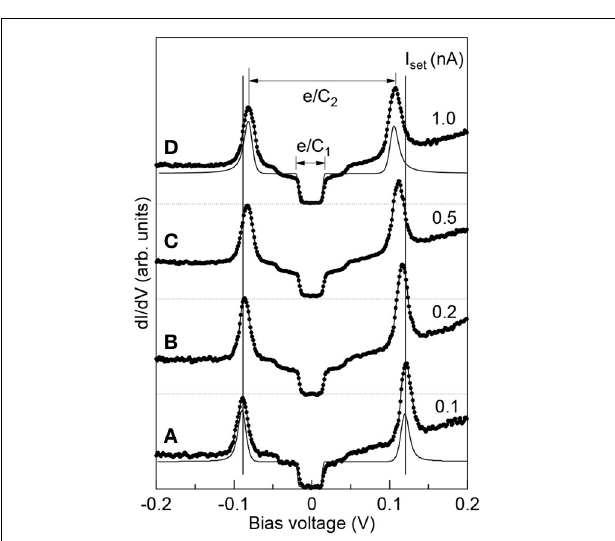
FIGURE 4 | Evolution from Coulomb blockade to Coulomb staircase: experimental STS data acquired on a Pb island with 14nm side ( A island ≈ 85nm 2 ) (dots) and simulation (black line) based on the orthodox theory. The spectra are offset for clarity. Parameters of the simulation: R 1 = 39M (cid:3) , C 1 = 7 . 46aF, and C 2 = 0 . 7aF; (A) : R 2 = 300M (cid:3) and Q 0 = − 0 . 15 e , (B) : R 2 = 105M (cid:3) and Q 0 = − 0 . 2 e , (C) : R 2 = 26M (cid:3) and Q 0 = − 0 . 26 e , (D) : R 2 = 13M (cid:3) and Q 0 = − 0 . 26 e , (E) : R 2 = 4 . 5M (cid:3) and Q 0 = − 0 . 28 e .